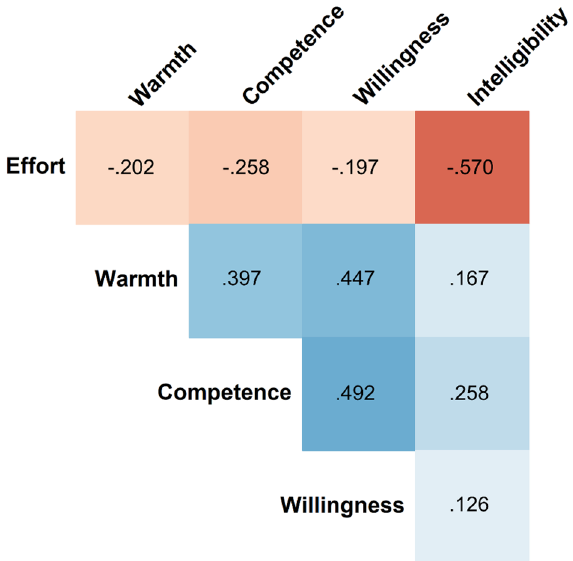
Figure 3. Correlations between all dependent variables. Values represent repeated-measures correlation coefficients. Cooler colors accompany positive correlations and warmer colors accompany negative correlations.